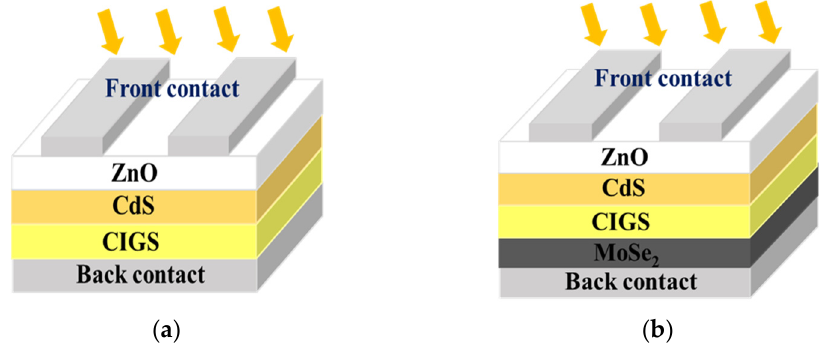
Figure 1. Schematic device structure of CIGS solar cell developed using SCAPS interface ( a ) reference model without MoSe 2 layer ( b ) proposed model with MoSe 2 layer. Table 1. Summary of the Optical and Electrical Parameters Used for the Simulation Model.